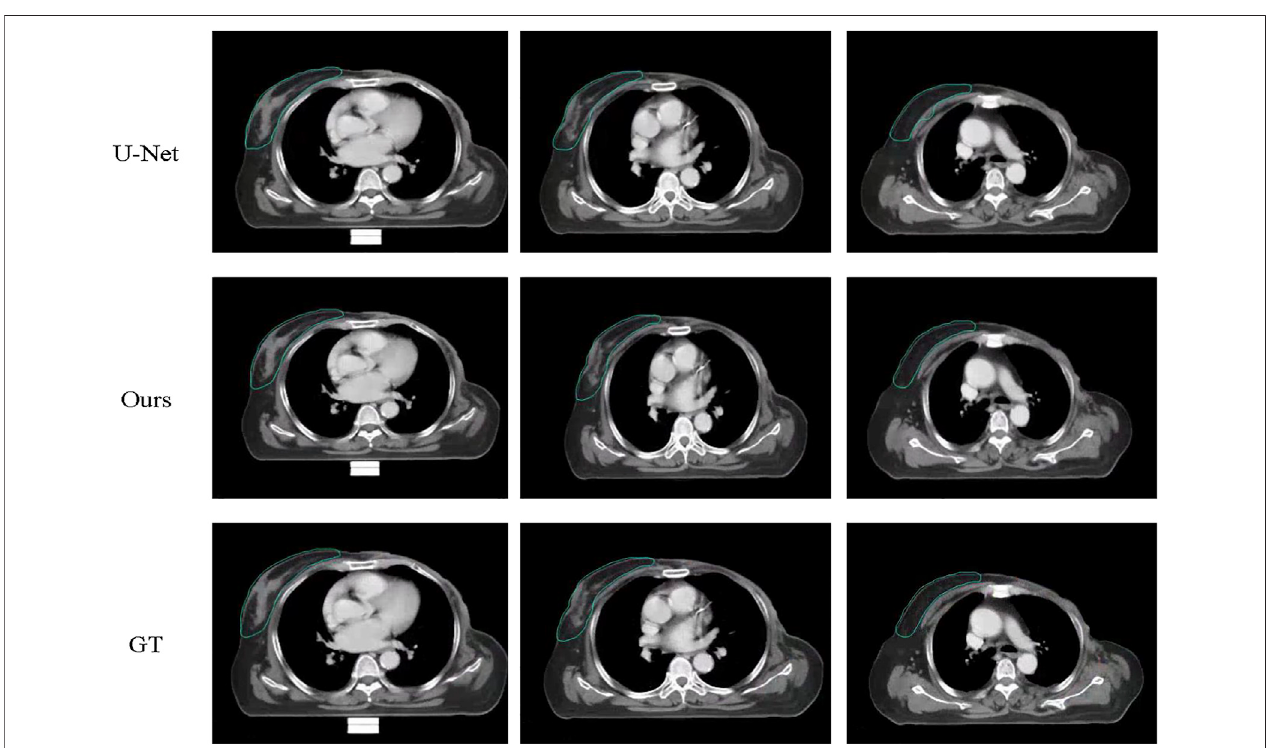
FIGURE 5 | Examples of segmentation results of U-Net and the proposed method against gold standard on the contralateral side. The fi rst image is the result of U-Net, the seconf is the ground truth while the third is our proposed method.